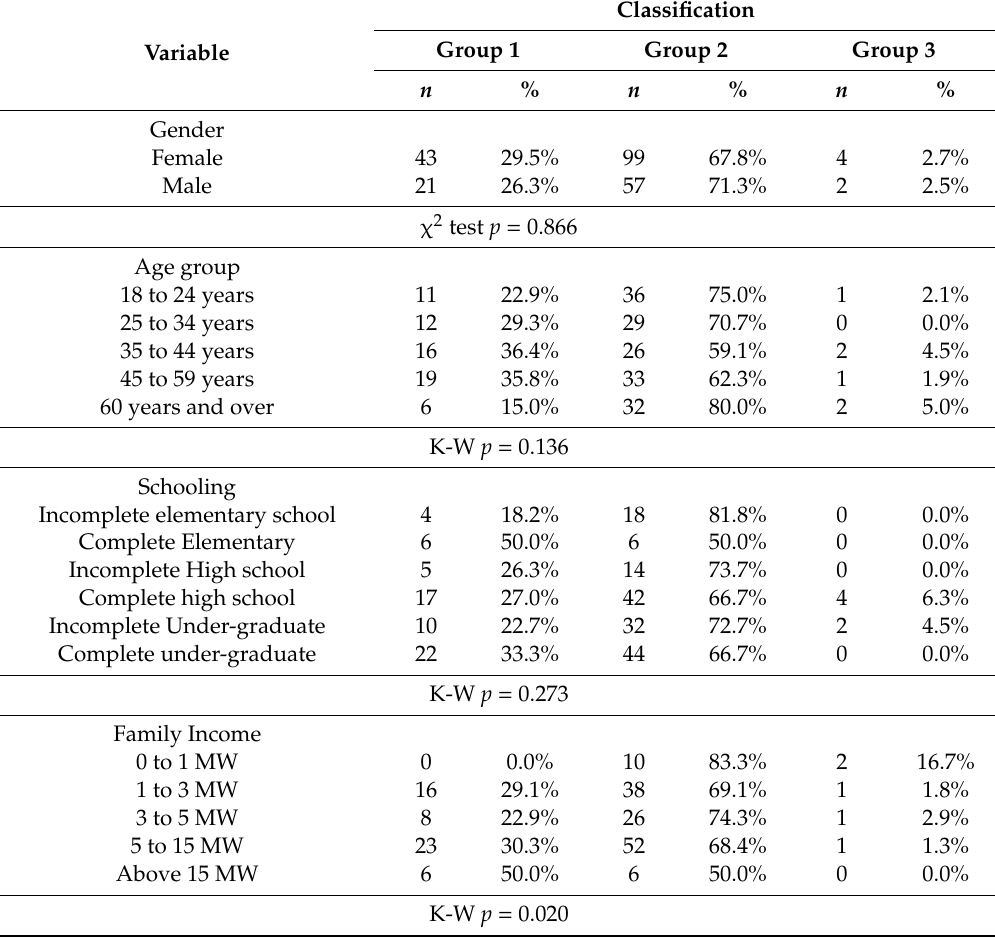
Table 4. Classification of the home kitchens according to the instrument and their relationship with socio-demographic data (gender, age, schooling, and family-wage income) in the Federal District, Brazil. Bras í lia, DF,